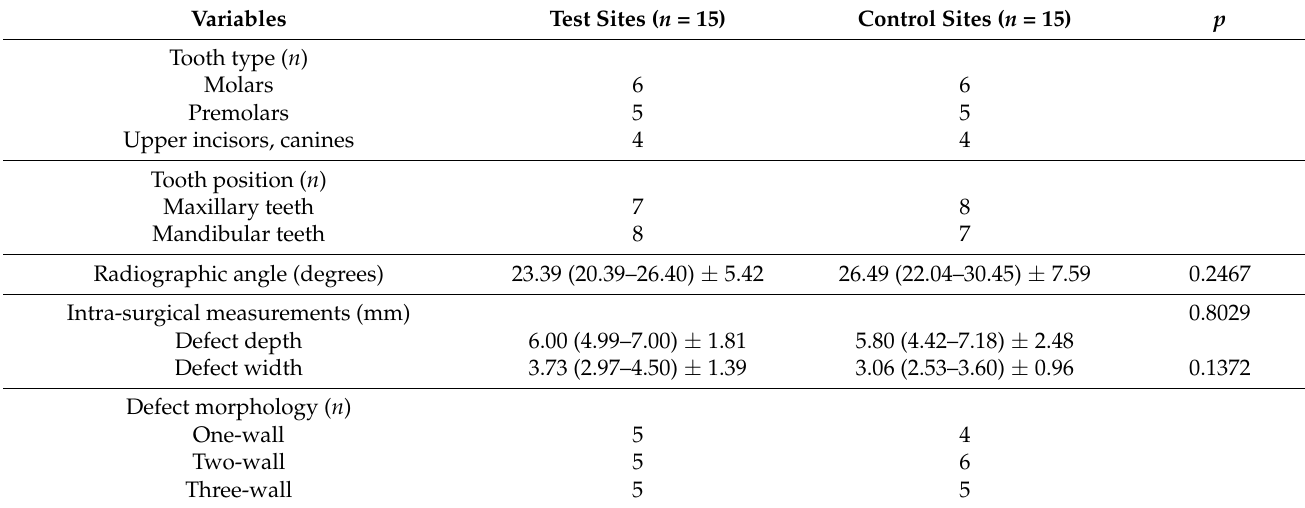
Table 1. Baseline clinical characteristics: tooth type, tooth position, radiographic angle (RVG angle), intra-surgical measurements, and defect morphology [mean, 95% confidence interval (CI), standard deviation